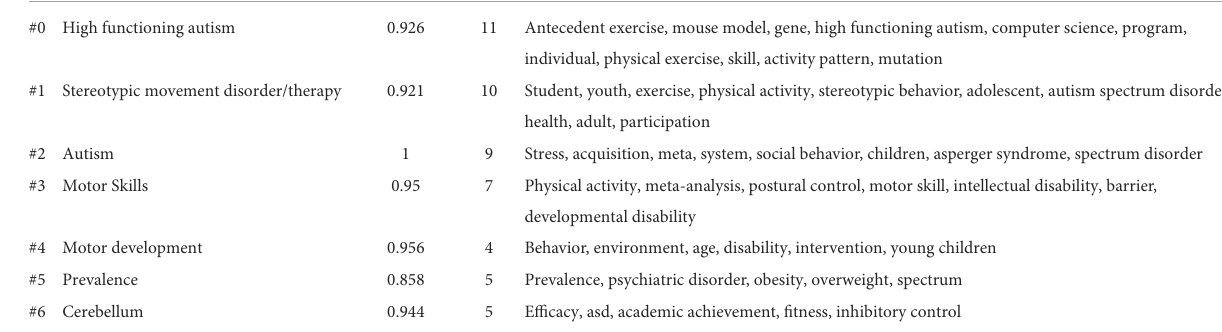
TABLE 4 Subjects of cluster analysis